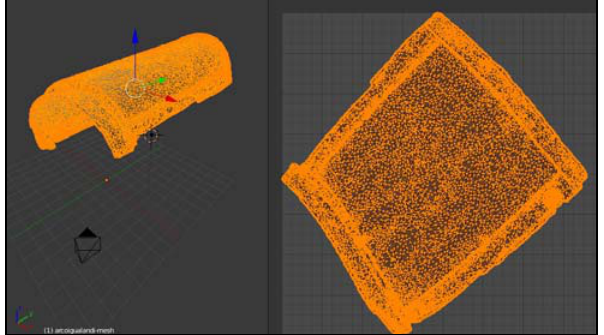
Figure 24 – View of the process to unwrap the Low Poly Mesh in Blender software.